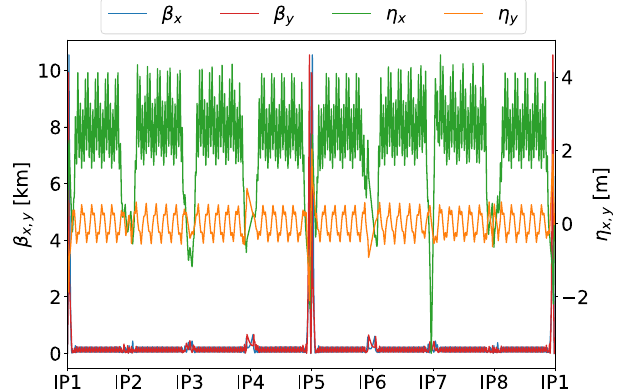
FIG. 17. Optics functions before spurious dispersion correc- tion, arising from a crossing angle for the 18 × 90 lattice without dispersion suppressor collimators.